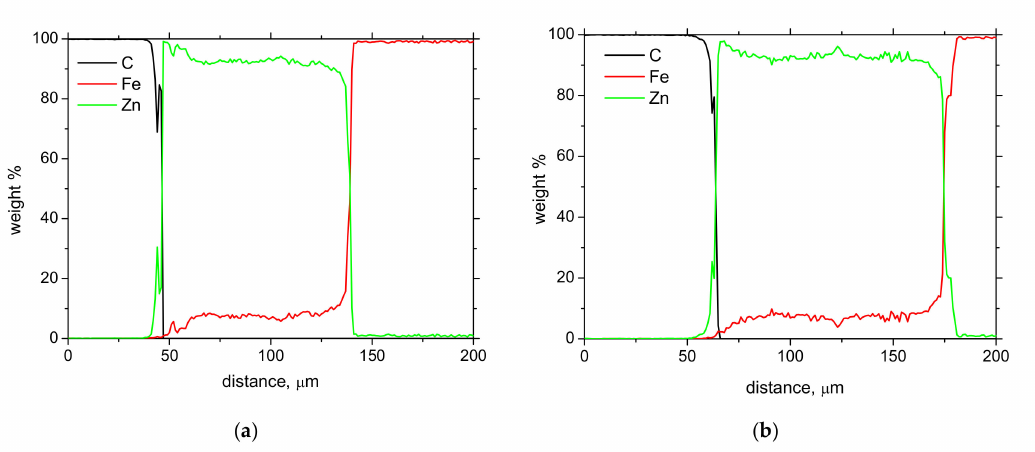
Figure 7. Local chemical analysis. ( a ) Coating thickness 101 ± 4 µ m, ( b ) coating thickness 144 ± 6 µ m.